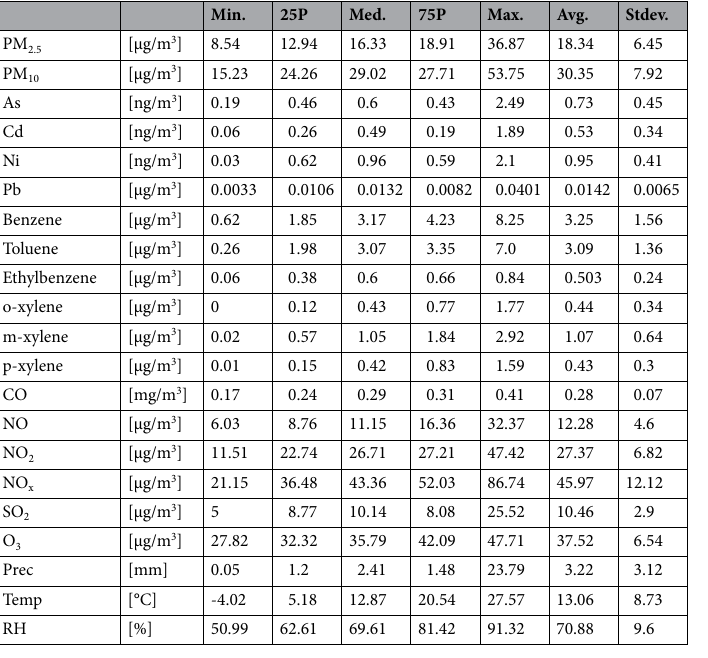
Table 2. Descriptive statistics of the parameters studied from the six automated stations in Ploie ș ti during